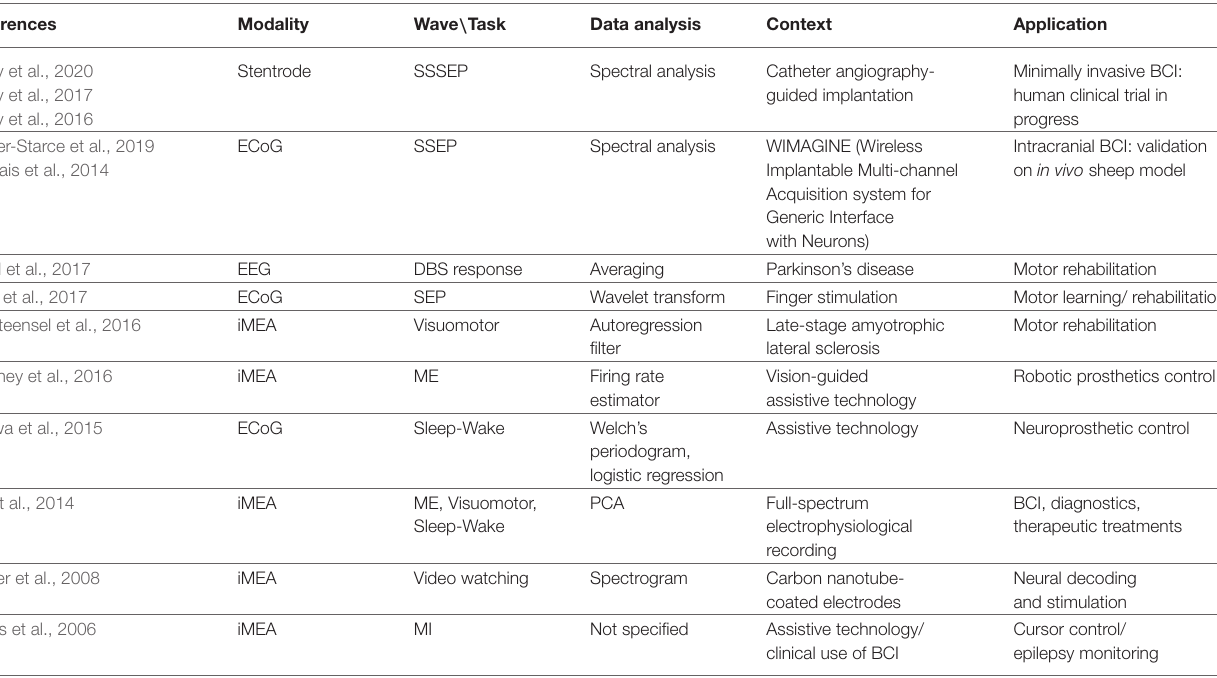
TABLE 5 | A summary of brain computer interface (BCI) studies involving invasive